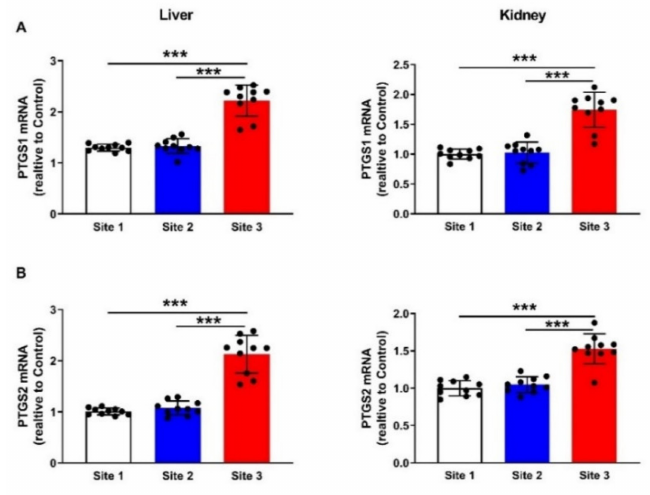
Figure 9. PTGS1 ( A ) and PTGS2 ( B ) mRNA levels in the liver and kidney of camels at the studied sites. Data are mean ± SD ( n = 10). *** p < 0.001.